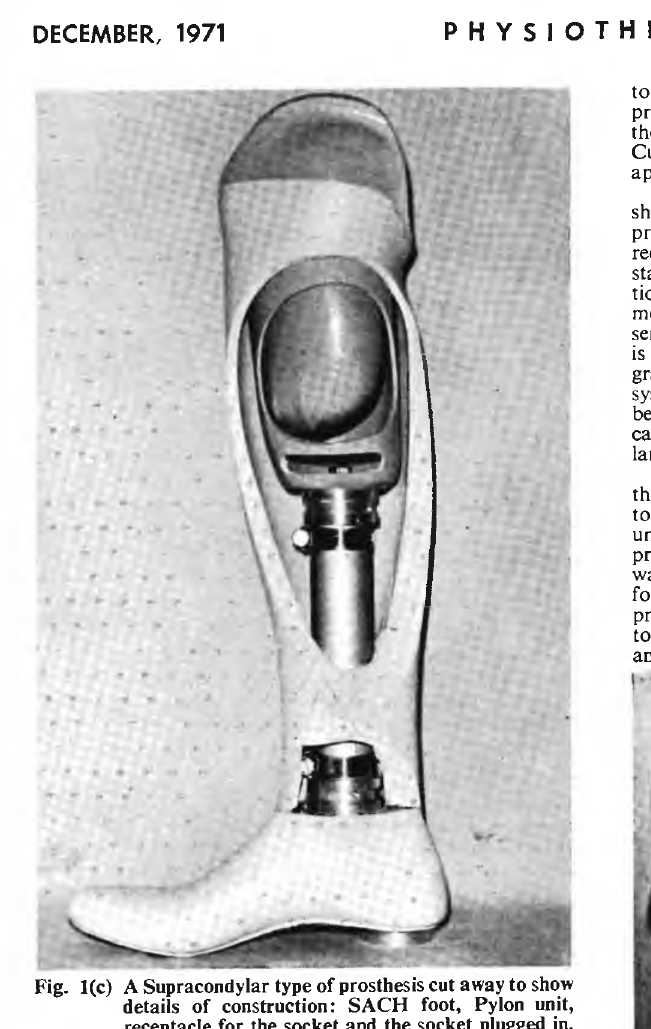
Fig. 1(c) A Supracondylar type of prosthesis cut away to show details of construction: SACH foot, Pylon unit, receptacle for the socket and the socket plugged in.